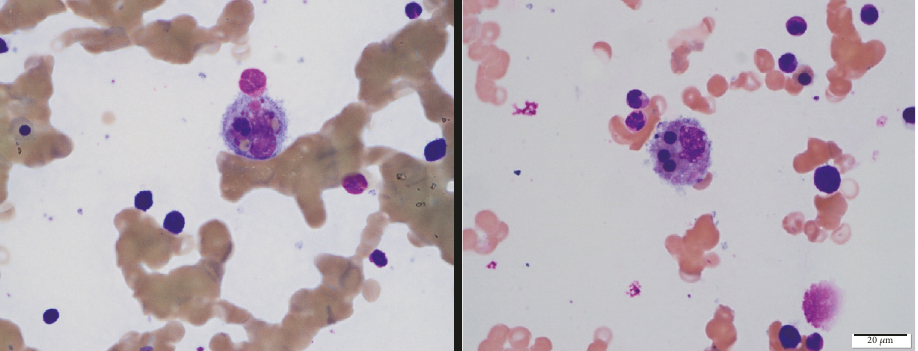
Figure1:Bonemarrowaspiratedemonstratinghemophagocytichistiocyteswithengulfednucleatederythroidprecursors(right)andplatelets and neutrophils